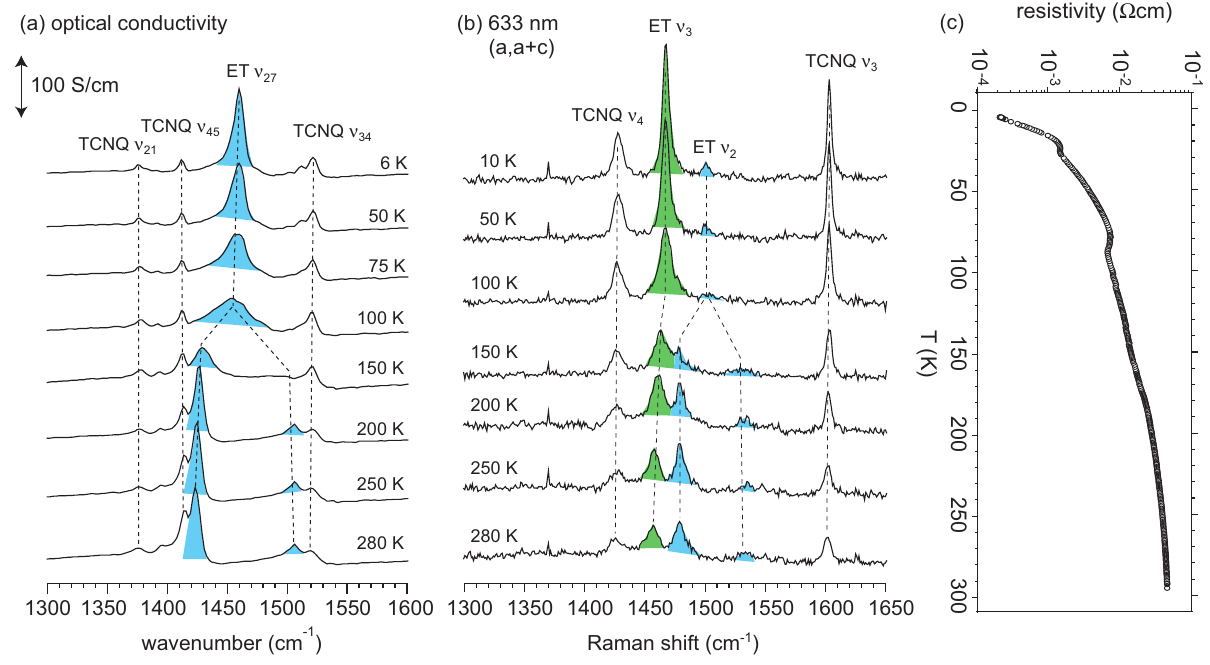
Figure 6. Temperature dependences of the ( a ) ν modes; and ( c ) electrical resistivity of BEDT-TTF in β″ -(BEDT-TTF)(TCNQ). Note that the charge-sensitive modes merge into a single band on decreasing the temperature. This figure is modified from Figures 3,4,7 in ref.